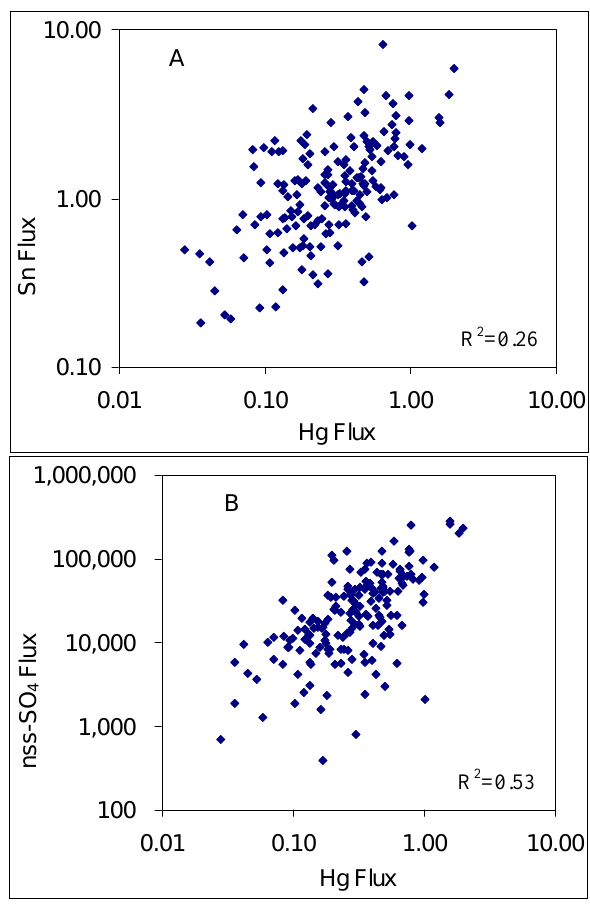
Fig. 7. Scatter plots of the rainfall deposition data for Sn vs. Hg (A) , and nss-SO 4 vs. Hg (B) . Correlation coefficients (R 2 ) are from lin- ear regression analysis. All flux units are µg/m 2 per rain event. Log axes are used to display the full range of the